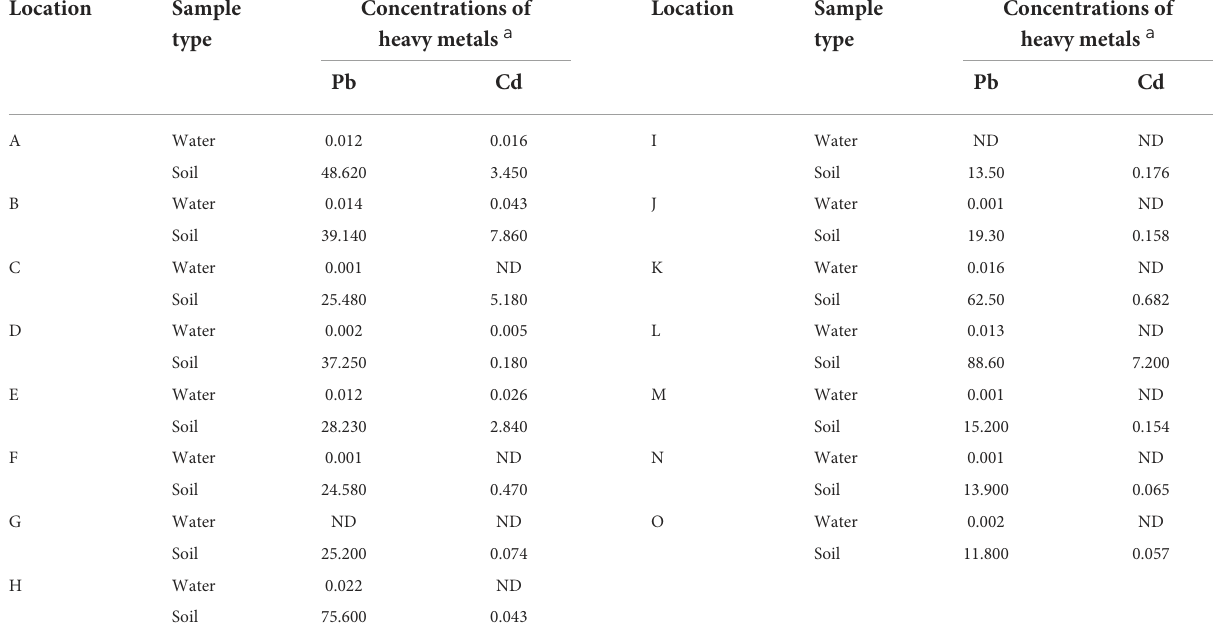
TABLE 1 Concentrations of Pb and Cd in water and soil of different sampling areas. Location Sample Concentrations of Location Sample Concentrations of